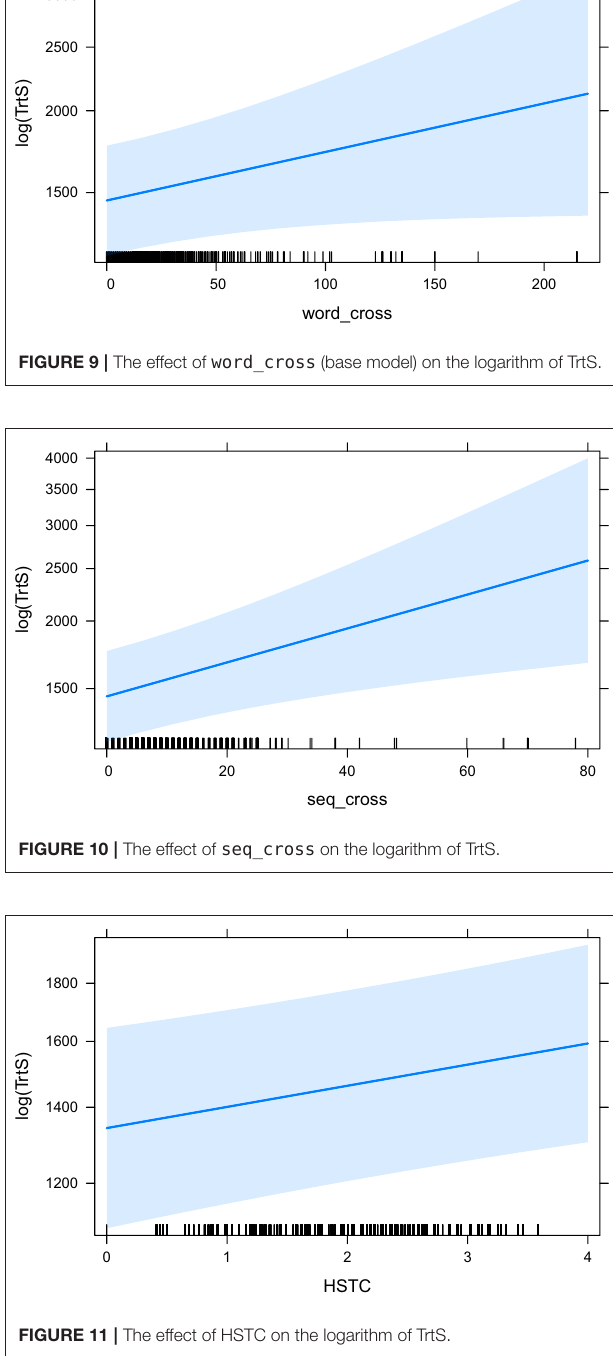
difference in R 2 is minimal. All predictors explain more variance in TrtS than any predictor could in EKS. The reason for this may lie in late, conscious processes. Even after a translation is being generated (EKS is the time from the first fixation on a word until the first keystroke that contributes to its